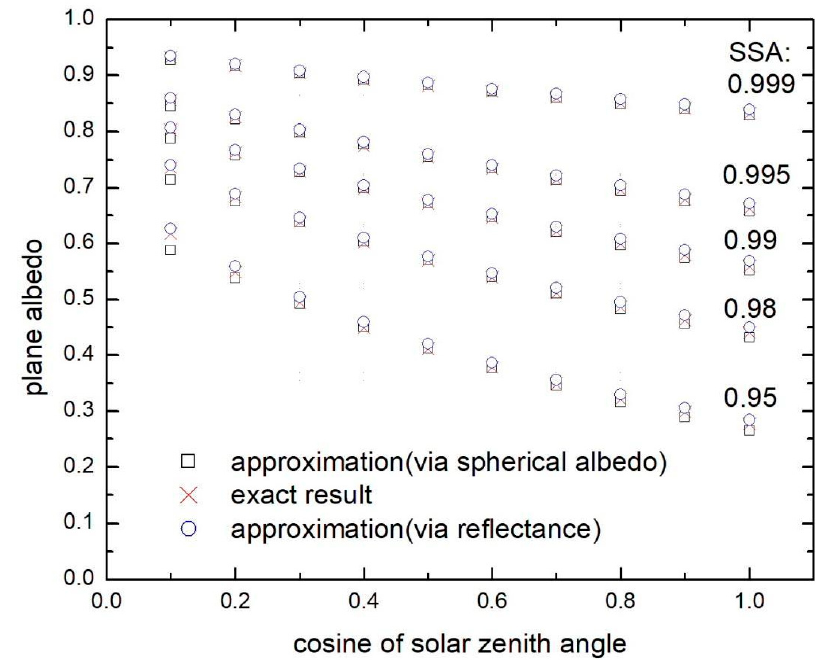
Figure 3. The plane albedo as the function of the cosine of the solar zenith angle at various values of single scattering albedo for the semi-infinite snow layer with the asymmetry parameter g = 0.75. The exact results are presented together with two approximations (boxes-Equation (13), circles-calculation of plane albedo using Equations (15) and (16)).